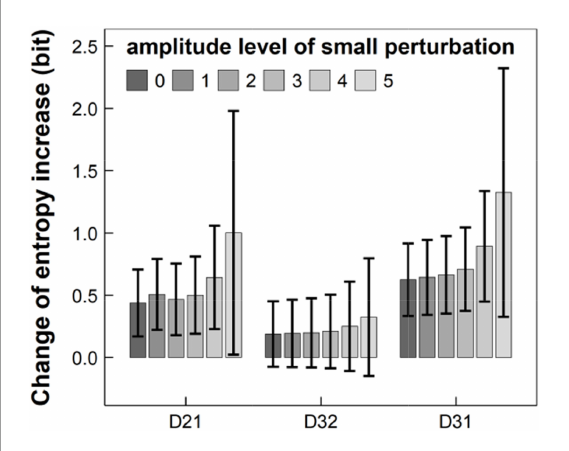
FIGURE6 Entropy increases D 21 , D 32 , and D 31 changed with the amplitude of small perturbation, ranging from level 0 to 5, where TTN remained unchanged. TTN, total time of